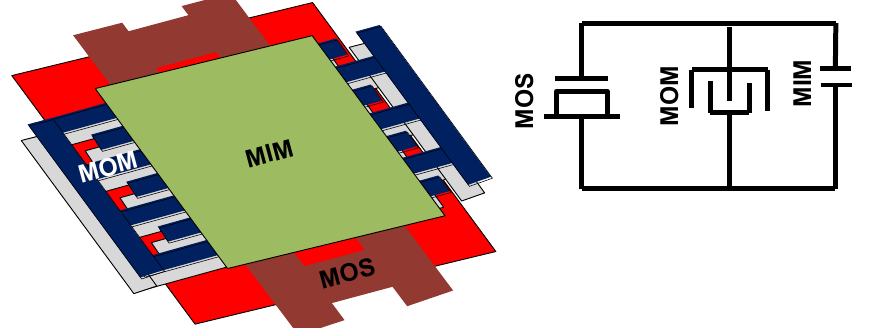
Figure 9. BGR and the reference current generator.